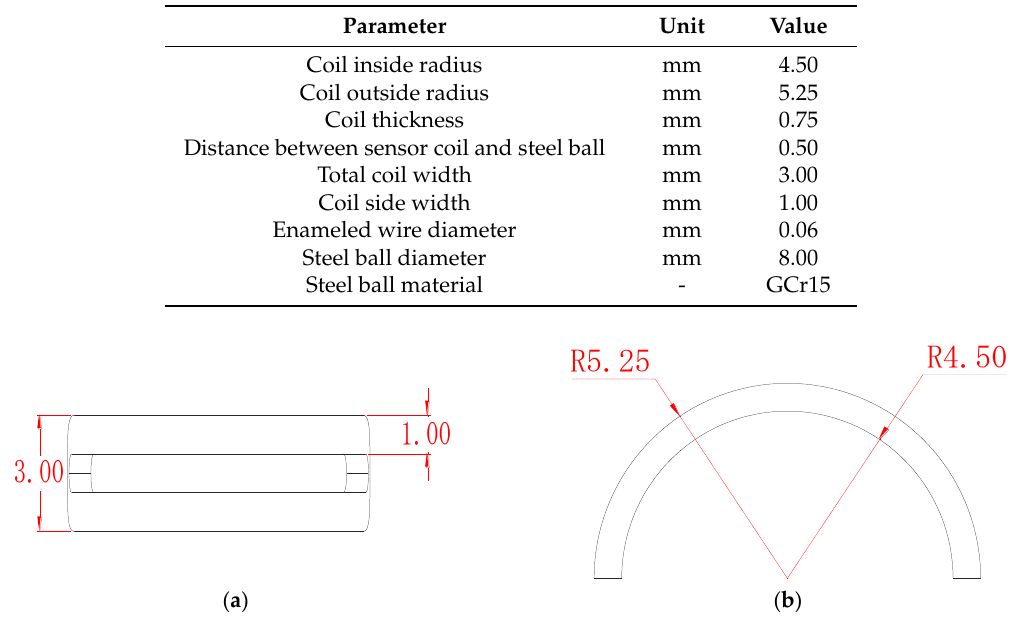
Table 1. Parameters of the sensor coil.